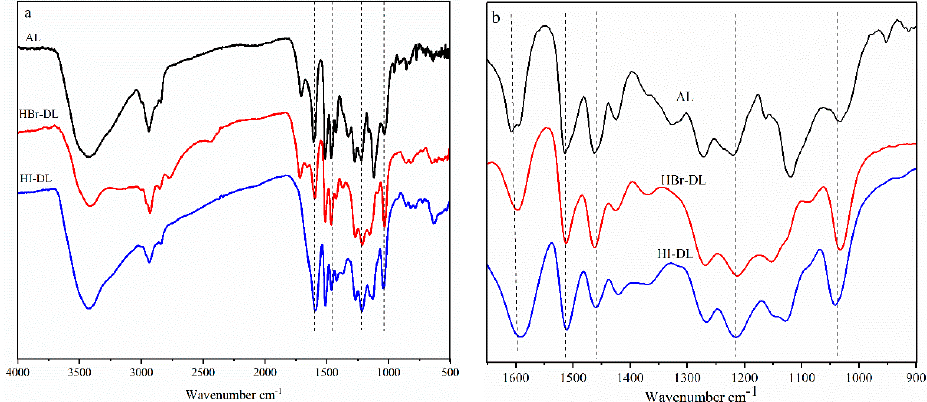
Figure 2. ( a ) FT-IR spectra of alkali lignin (AL) and demethylated lignins (DL) with HBr or HI as the reagent; ( b ) enlarged spectral region shows signals of particular interest.